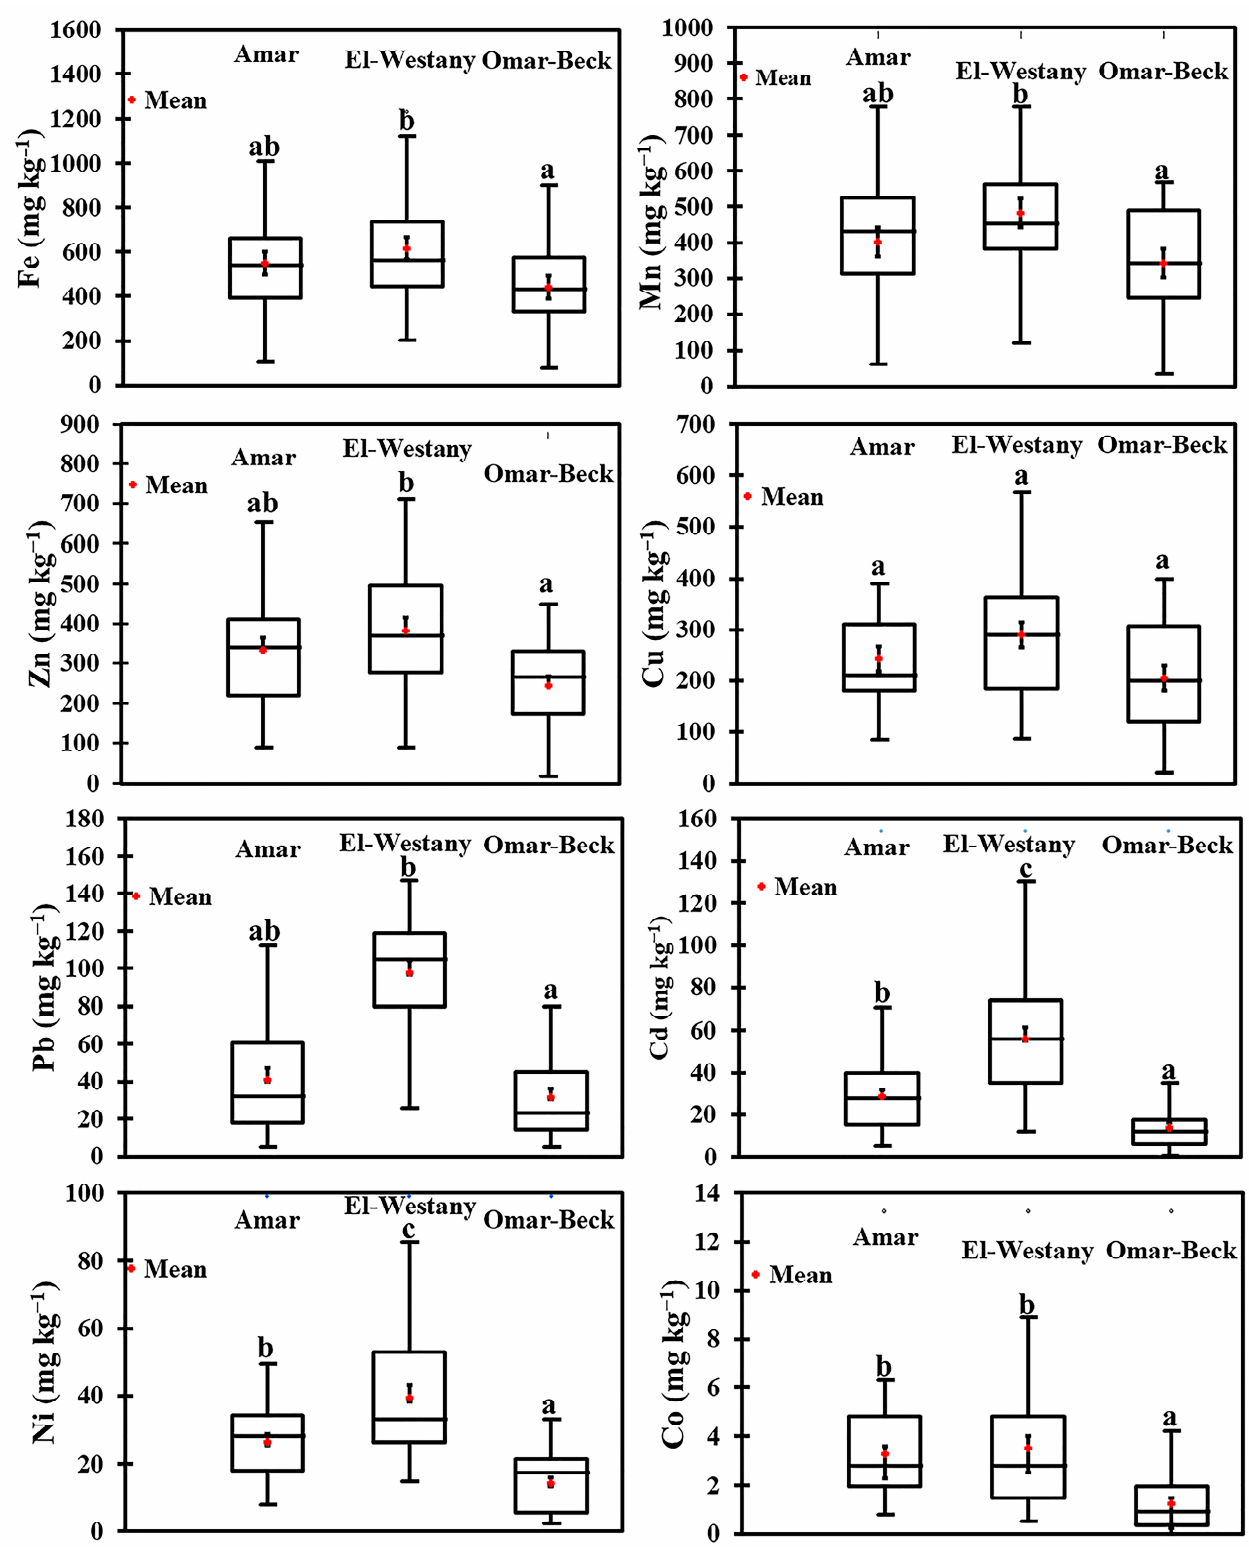
Figure 2. Box plots show the mean values (+red) and standard errors (internal vertical bars) of the measured sediment heavy metals of the three drains (Amar, El-Westany, and Omar-Beck) in the Nile Delta of Egypt. External upper and lower vertical bars display the maximum and minimum values of heavy metals, respectively. Different letters indicate statistically significant differences at p ≤ 0.05 according to the Kruskal–Wallis